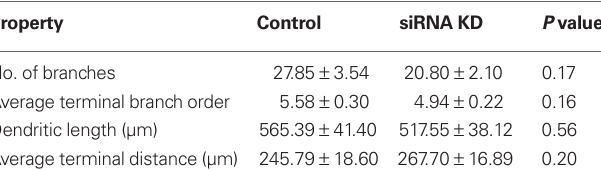
Figure 5 | reductions in activity reduce the overall complexity of newborn ABNs. (A1) Classical Sholl analysis with radii increasing in 20 μm increments. Sholl analysis measures apical dendrite length within each sphere plotted against radius from soma. (A2) siRNA knock-down cells show a significant reduction in length in proximal-intermediate distances from soma (at 120 μm: p < 0.01, n = 20). (A3) NO cells show no significant differences in Sholl analysis. (B1) Modified Sholl analysis of branch intersections. Modified Sholl analysis represents the number of branches at a fixed distance along the apical dendrite (not counting terminated branches). (B2) siRNA knock-down cells show a